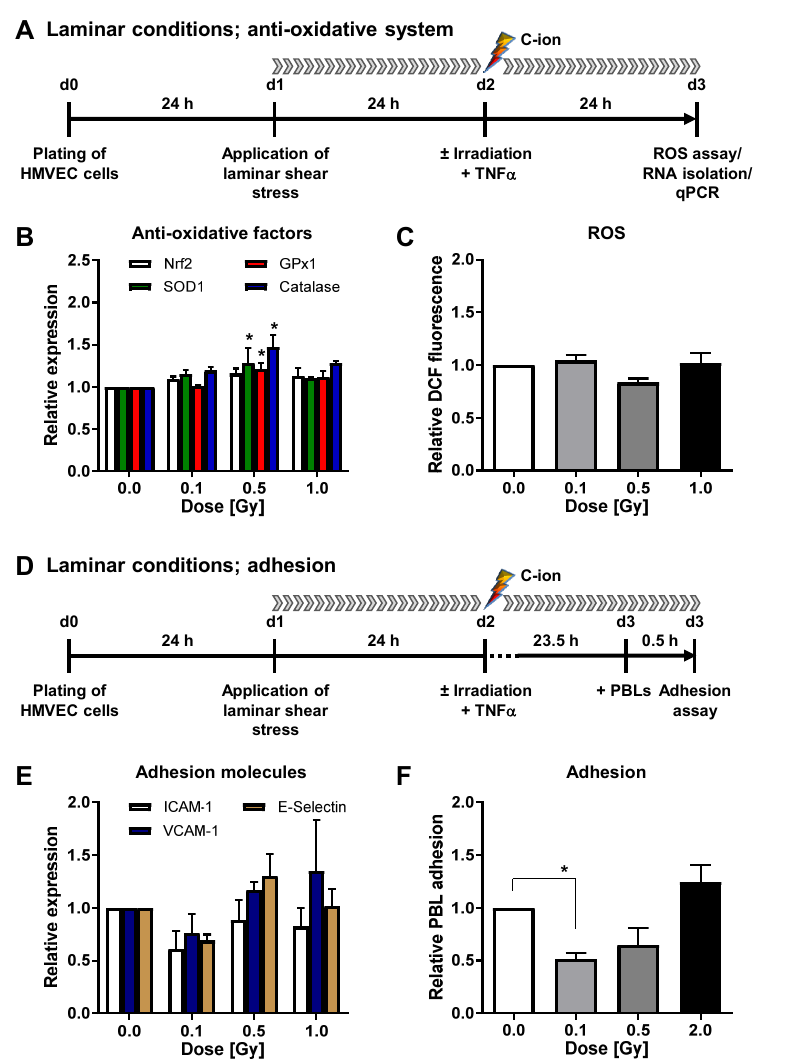
Figure 4. Carbon ion irradiation modulates the anti-oxidative defense of HMVEC cells and leukocyte adhesion. ( A ) Experimental settings: At 24 h after plating, HMVEC cells were exposed to laminar shear stress conditions. Irradiation with Carbon (C)-ions and TNF- α stimulation was applied. After 24 h, cells were collected, followed by ROS analysis and RNA isolation. ( B ) mRNA expression of anti ‐ oxidative factors was measured by qPCR and values were displayed relative to non ‐ irradiated cells (mean + SEM; n = 4; * p < 0.05, Kruskal ‐ Wallis test vs. 0 Gy). ( C ) ROS analysis was performed by flow cytometry (mean + SEM; n = 4). ( D ) For adhesion experiments, PBL were added 23.5 h after irradiation to the flow chamber and adhesion was subsequently measured by microscopic evaluation. ( E ) mRNA expression of indicated adhesion molecules relative to non ‐ irradiated cells is shown (mean + SEM; n = 3–4). ( F ) Adhesion of PBL was calculated relative to non ‐ irradiated samples (mean + SEM; n = 6; * p < 0.05, one ‐ way ANOVA vs. 0 Gy).